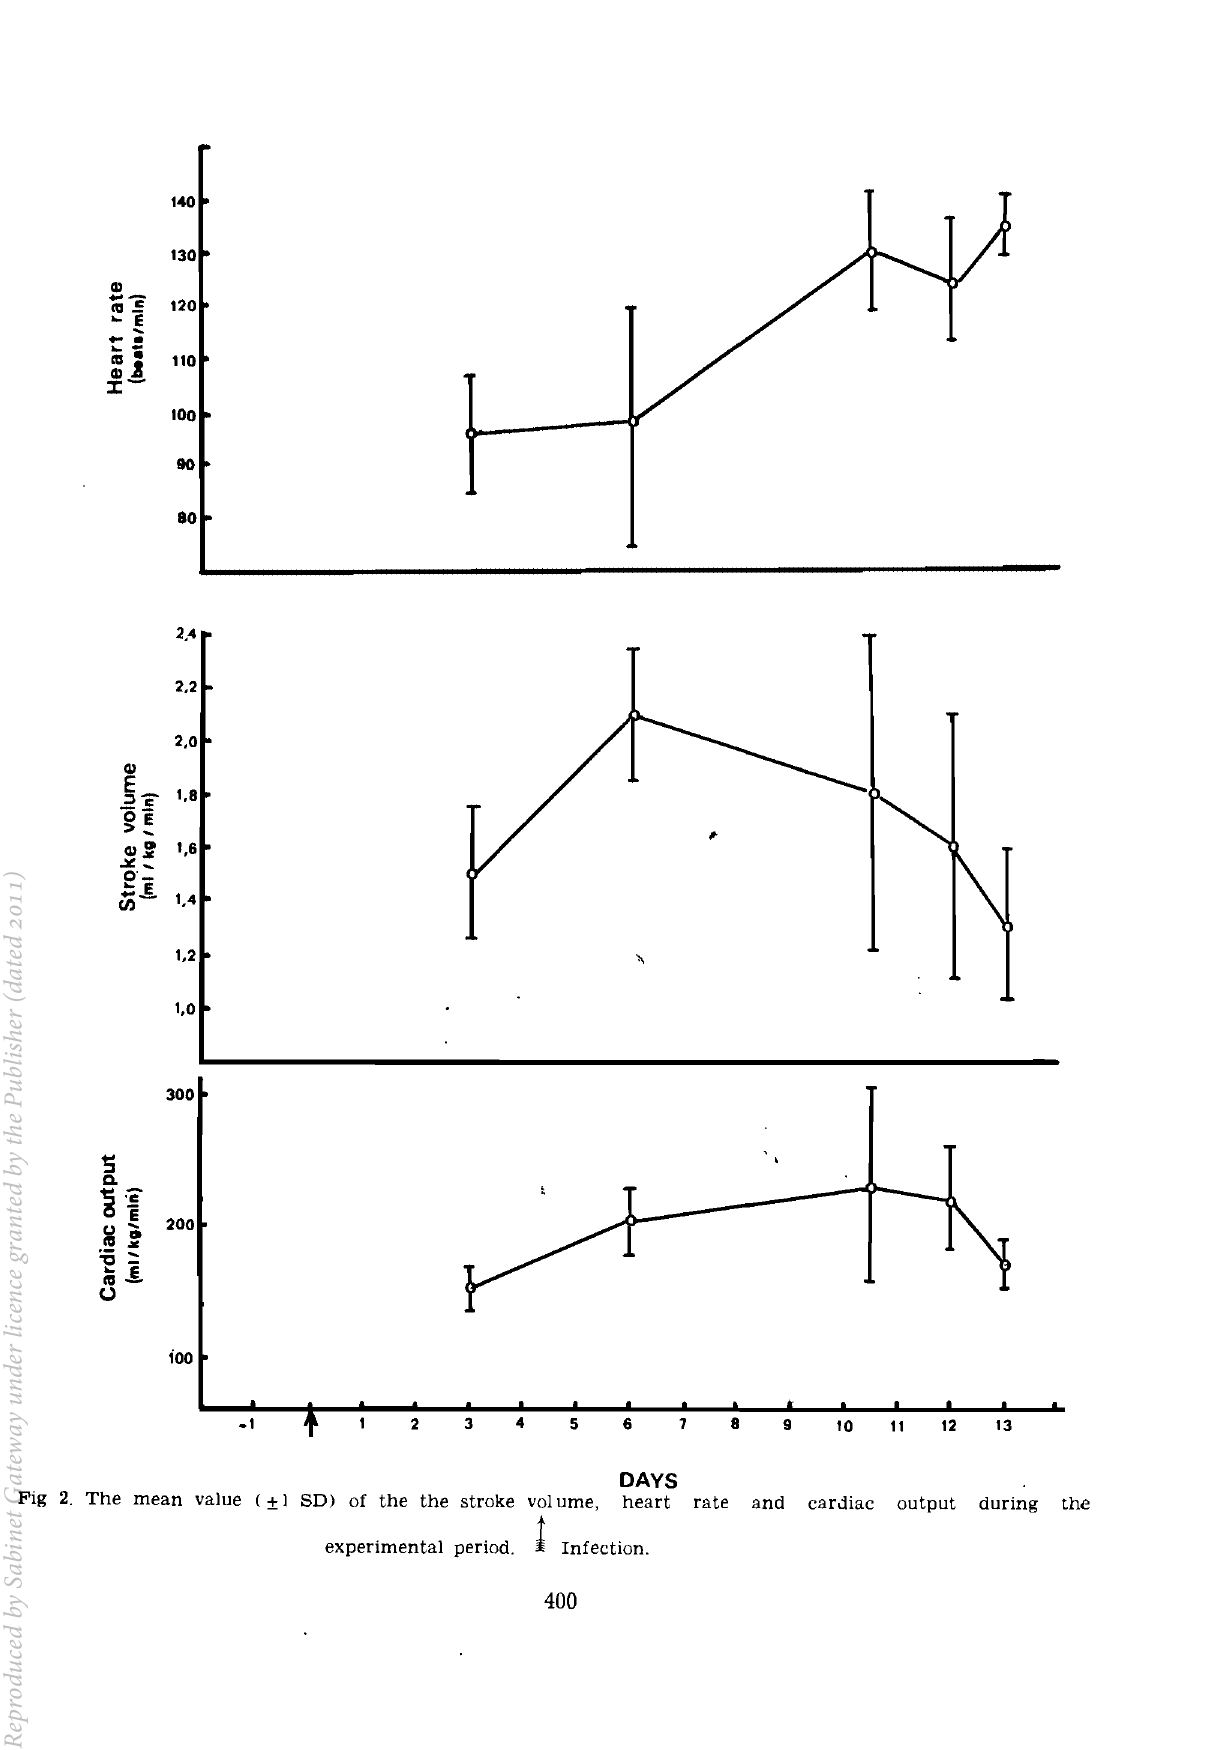
DAYS Fig 2. The mean value (± I SD) of the the stroke vol ume, heart rate and cardiac output during the * experimental period.